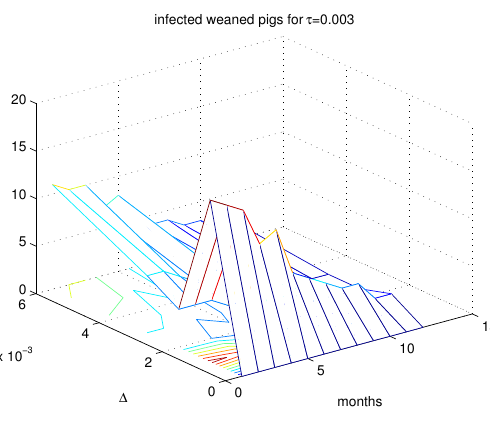
Fig. 4 Infected weaned pigs evolution during a whole year. Here we fix the value of external contamination rate at τ = 0 . 003.